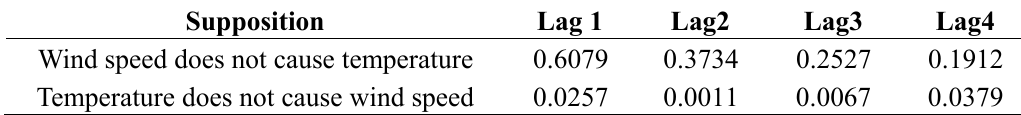
Table 3. Probability to reject in Granger causality test between wind speed and temperature.